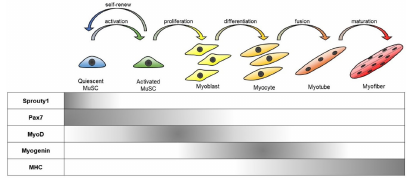
Figure 1. Stepwise muscle di ff erentiation from muscle satellite (stem) cells (MuSCs). Quiescent MuSCs express Pax7 without expression of MRFs. Activated MuSCs proliferate and irreversibly di ff erentiate into proliferating myoblasts that express the myogenic transcription factors including MyoD. Myoblasts further di ff erentiate into myocytes with the expression of other MRFs such as Myogenin and MRF4. Then, myoblasts cease proliferation and fuse to form a multinucleated myotube. Myotubes undergo further maturation and bundle together as